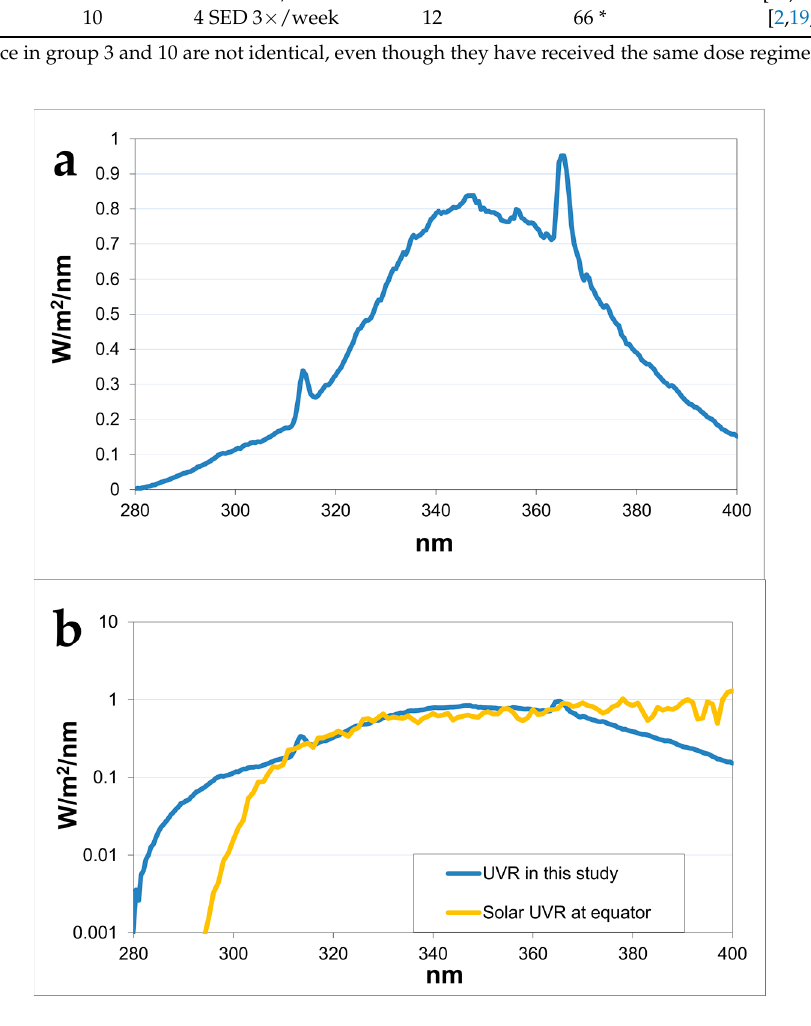
Figure 2. UVR spectra ( a ) Spectrum of the UVR used in this study, consisting of one Philips TL12 tube placed between five Bellarium-S SA-1-12 tubes; ( b ) Spectra from UVR used in this study (blue) and solar UVR at equator (orange) measured in the Spring, clear sky, solar height of 88° with an ozone layer of 250 DU and a UV-index of 11.6 (0.9 × 11.6 = 10.4 SED/h.